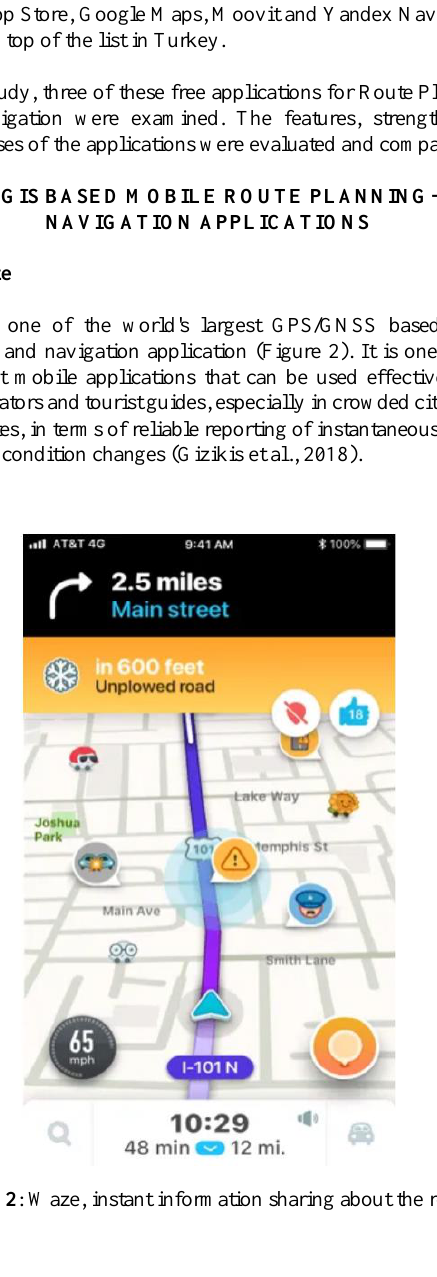
Waze's data source is users and acquires data with feedbacks. It is a navigation application powered by the participation of